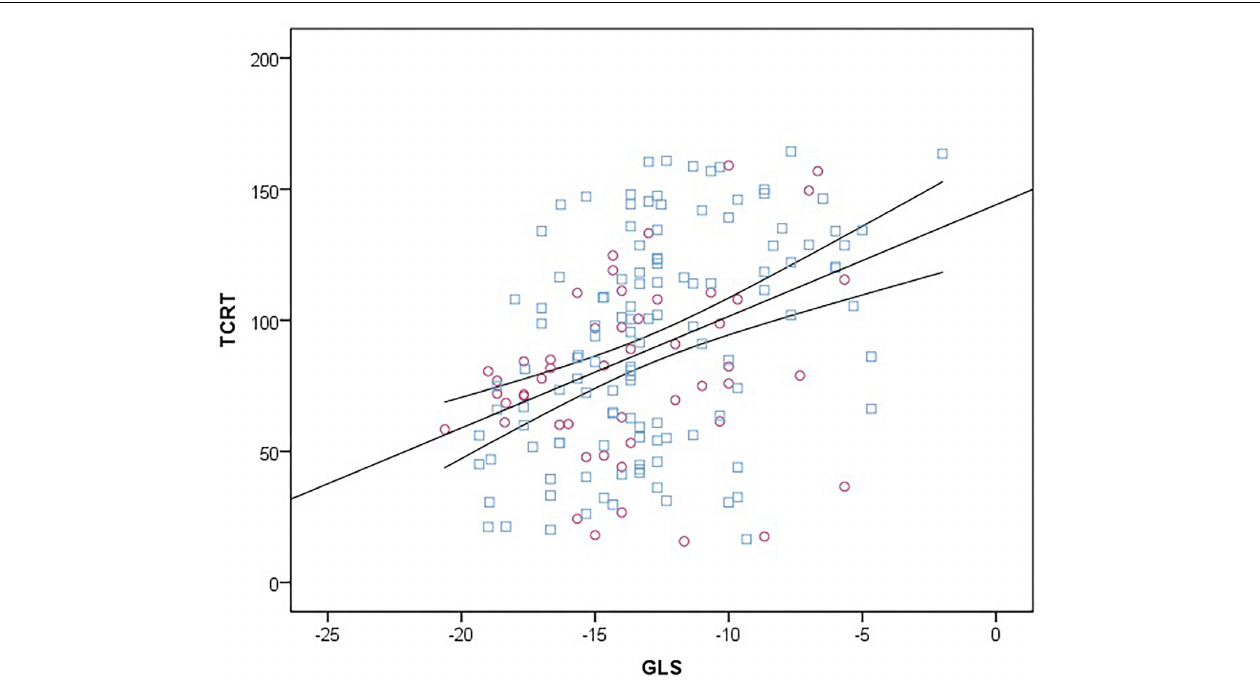
FIGURE 2 | Scatter diagram between TCRT and GLS at baseline. Female subjects are represented with purple circles and male subjects with blue squares. Linear regression line (straight) is plotted with 95% confidence intervals (curved lines). TCRT, total cosine R to T; GLS, global longitudinal strain.